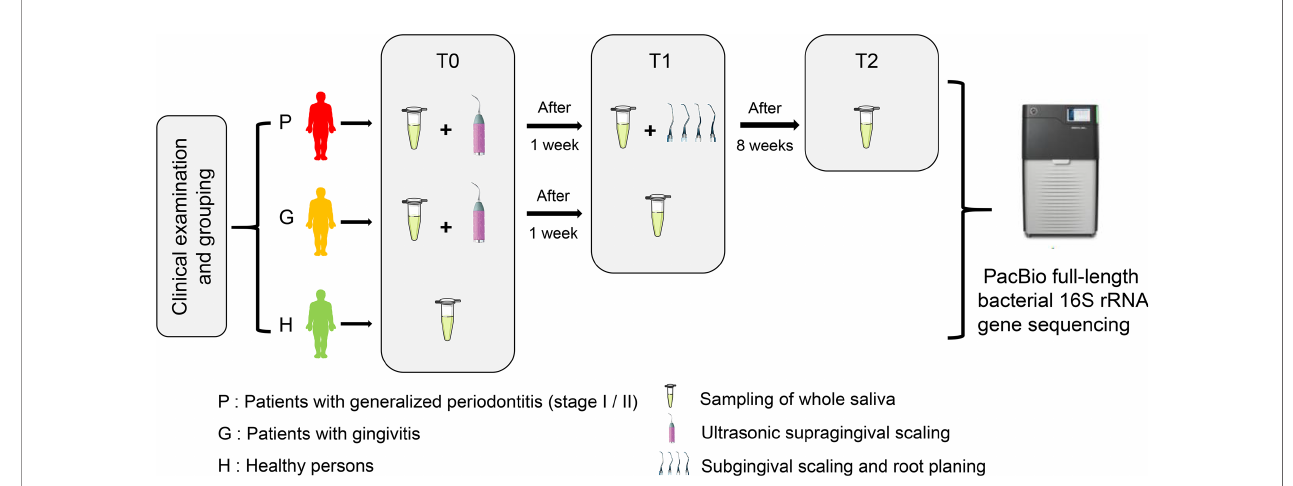
FIGURE 1 | The fl ow chart of this study showing the enrollment and classi fi cation of participants to subsequent microbiota